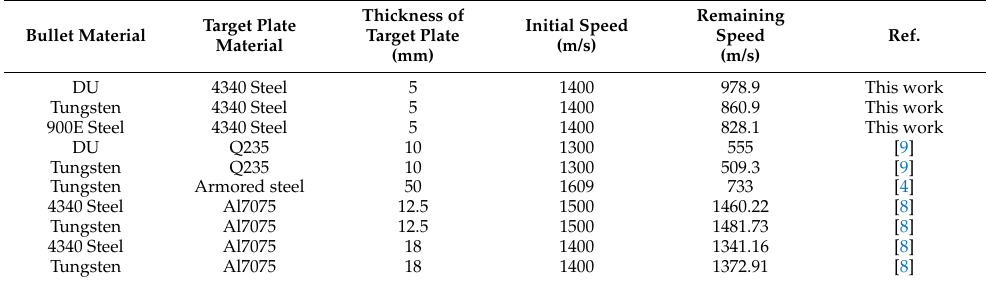
Table 3. Related parameters of penetration process of different